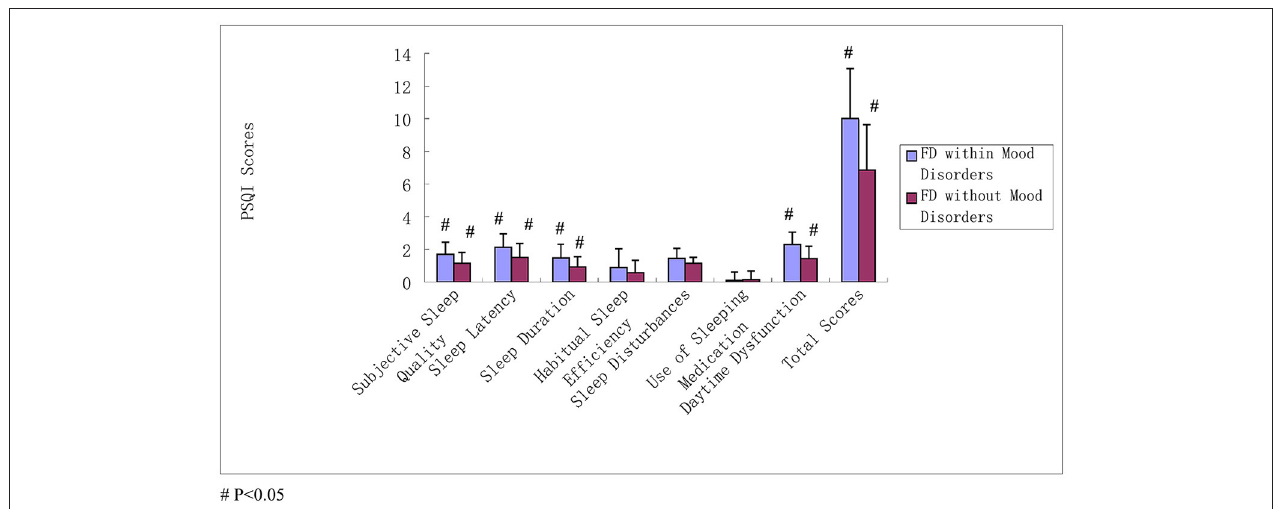
FIGURE 2 | PSQI scores between neonatal nurses in FD and mood disorders. The scores of subjective sleep quality, sleep latency, sleep duration, habitual sleep efficiency, sleep disturbances, daytime dysfunction, and total PSQI scores among neonatal nurses with FD-associated mood disorders were all higher than those exhibiting FD without mood disorders; the subjective sleep quality, sleep latency, sleep duration, daytime dysfunction, and total PSQI scores were statistically significant difference (all P <